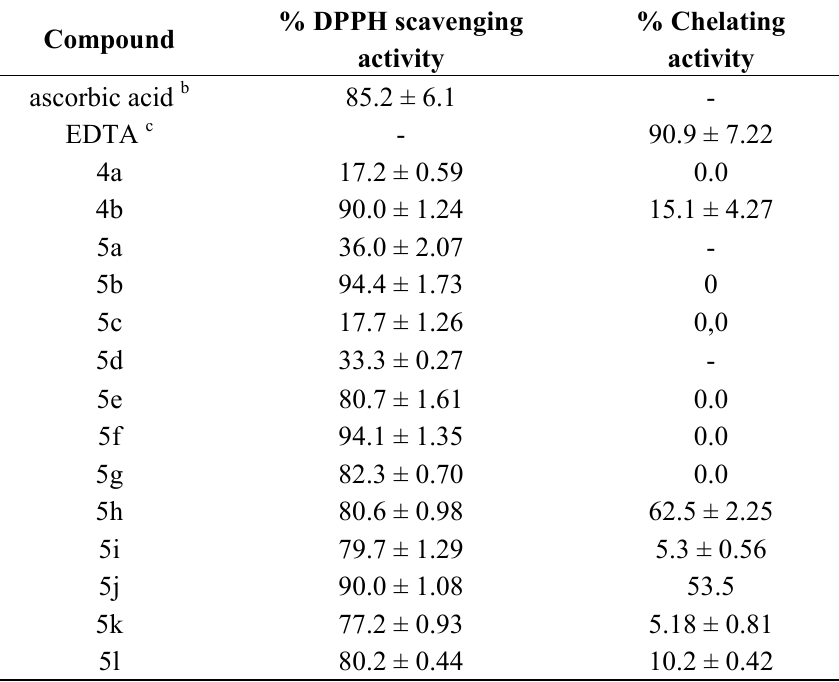
Table 1. DPPH scavenging activity and iron chelating activity of thiadiazine derivatives a